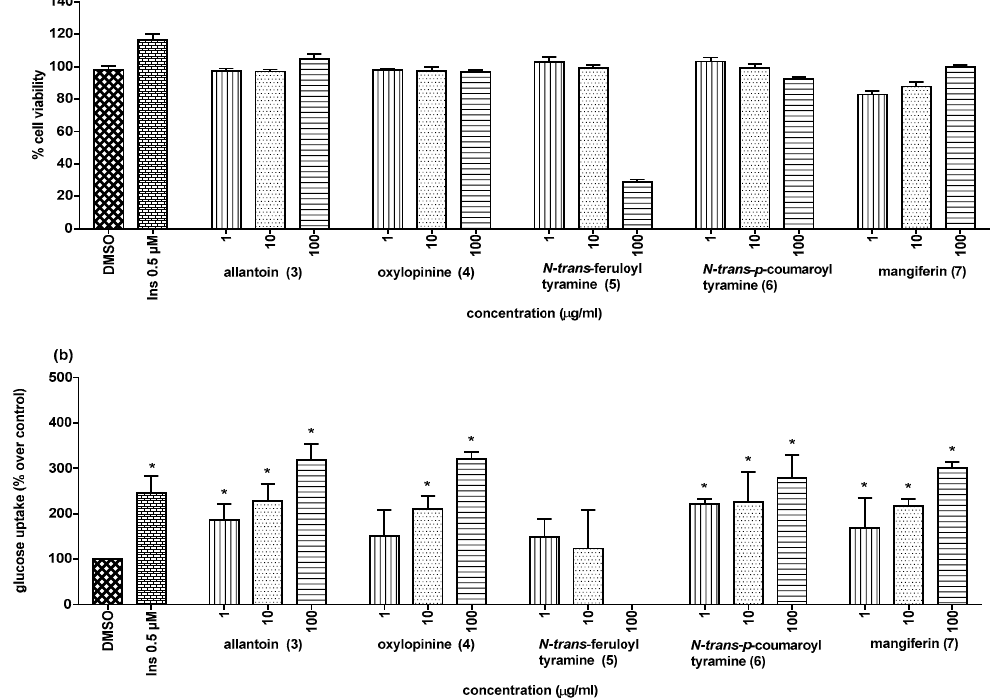
Figure 5. Cytotoxicity ( a ) and glucose uptake stimulation ( b ) of compounds from H. jenkinsii . * ( p < 0.05) Significantly different when compared to the control (DMSO); Ins = insulin (positive control).